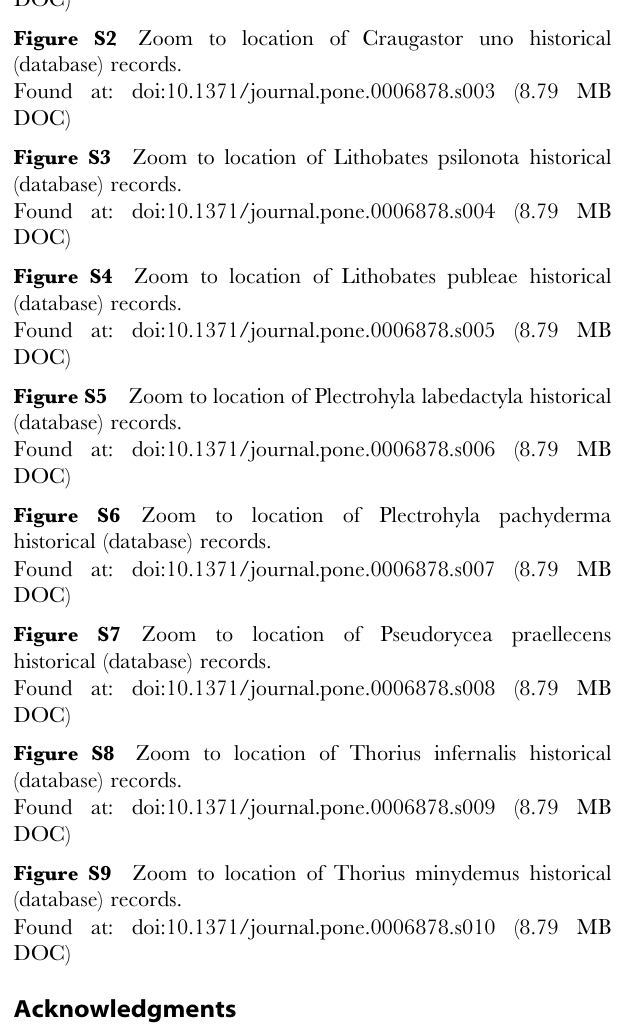
Table S1 List of the endemic Mexican amphibian species used